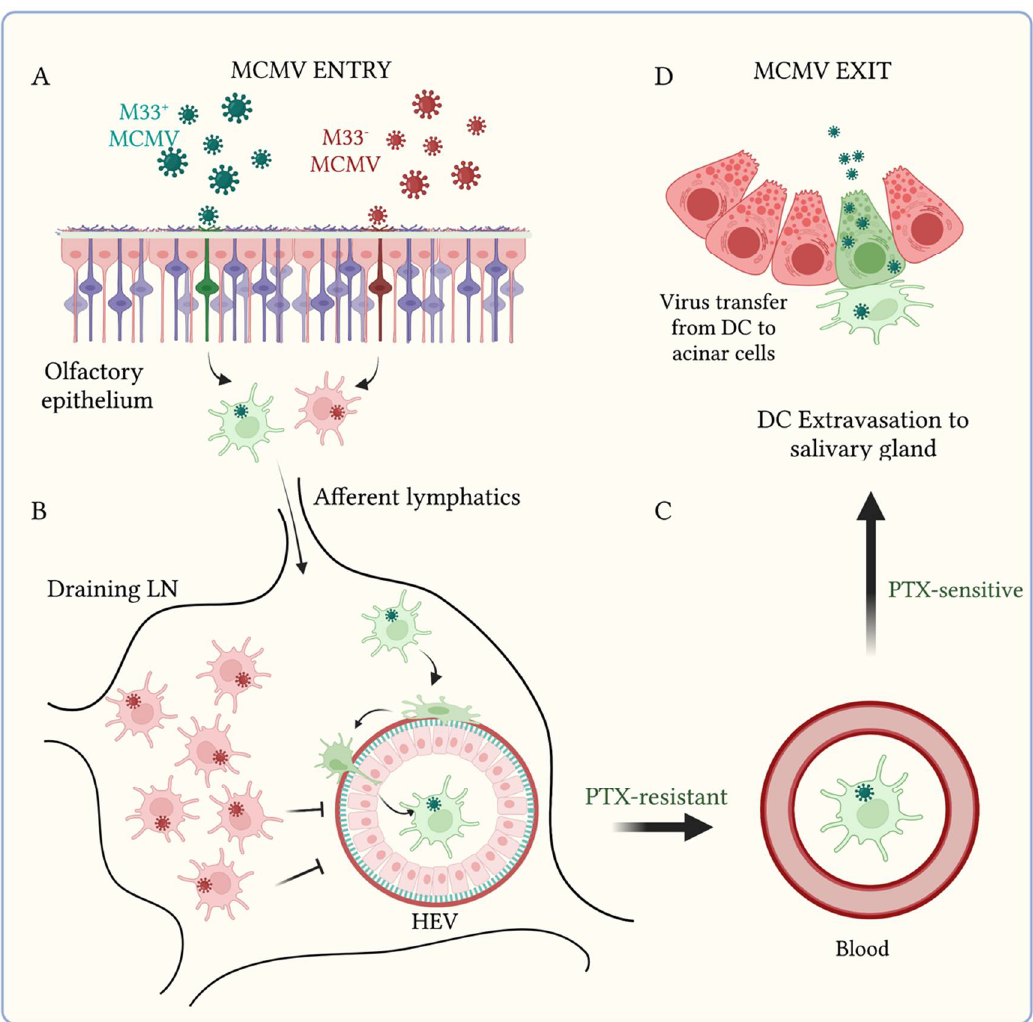
Figure 3. The MCMV encoded chemokine receptor M33 drives DC-dependent systemic spread via tissue-specific signaling mechanisms. Schematic showing the fate of M33 + and M33 − MCMV infections in vivo. ( A ) Mucosal infections at the olfactory or lung mucosa with either M33 + (green) or M33 − MCMV (red) spread via the afferent lymphatics to draining LN, facilitated by CD44 ( B ). DC infected with M33 + MCMV traffic to HEV and escape to the blood ( C ) via a mechanism resistant to pertussis toxin (PTX). In contrast, DC infected with M33 − MCMV show reduced association with HEV and viraemia and instead accumulate in LN. Blood-borne MCMV M33 + DC extravasate from the blood to the salivary glands via a PTX-sensitive mechanism, where genome amplification in acinar epithelial cells (green) precedes virus exit. ( D ).